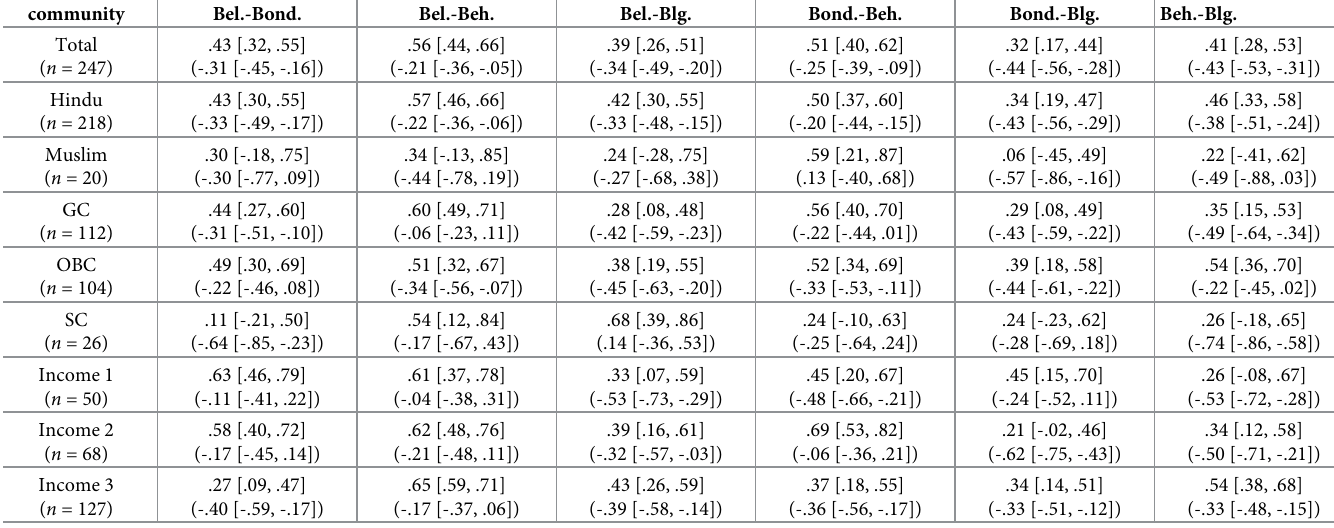
Table 17. Simple and partial (in parenthesis; after controlling religiousness) correlations between the dimensions of religiousness in social, economic, and religion groups among the community sample. community Bel.-Bond.